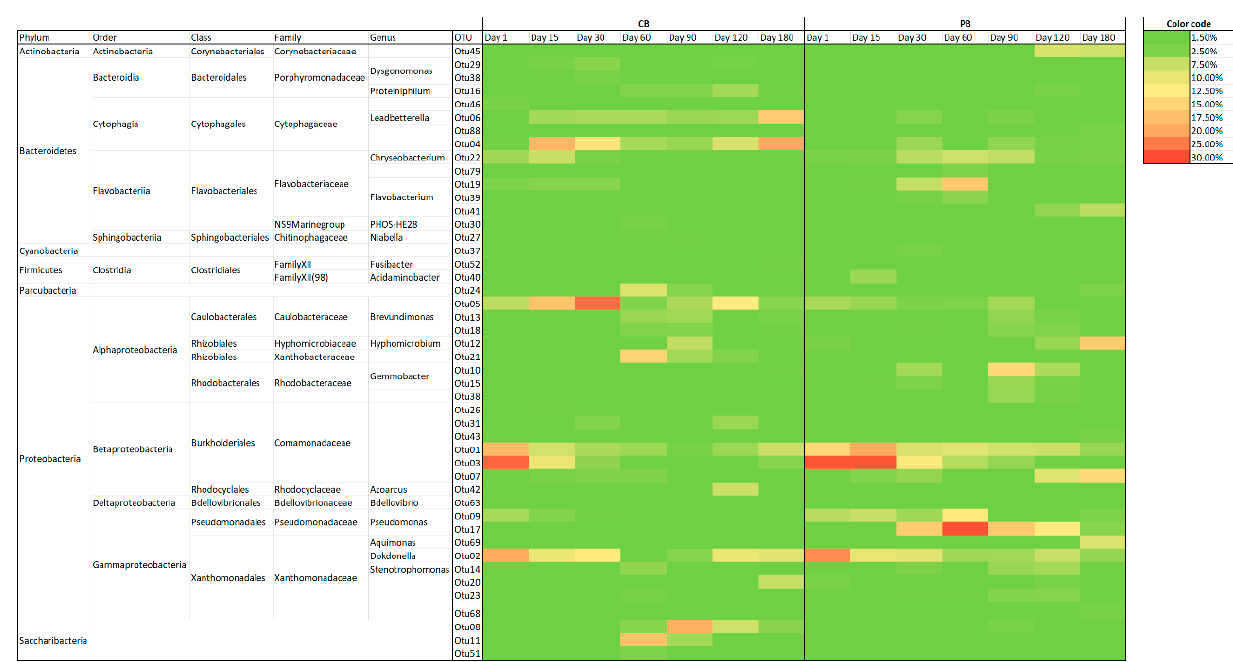
Figure 6. Distribution of the microbial community of DNA (>1.50%) in the reactors CB (control) and PB (supplemented with pharmaceuticals).